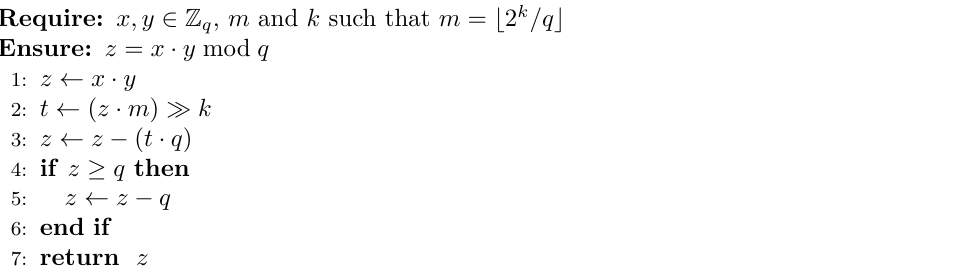
Algorithm 4 Modular Multiplication with Barrett Reduction